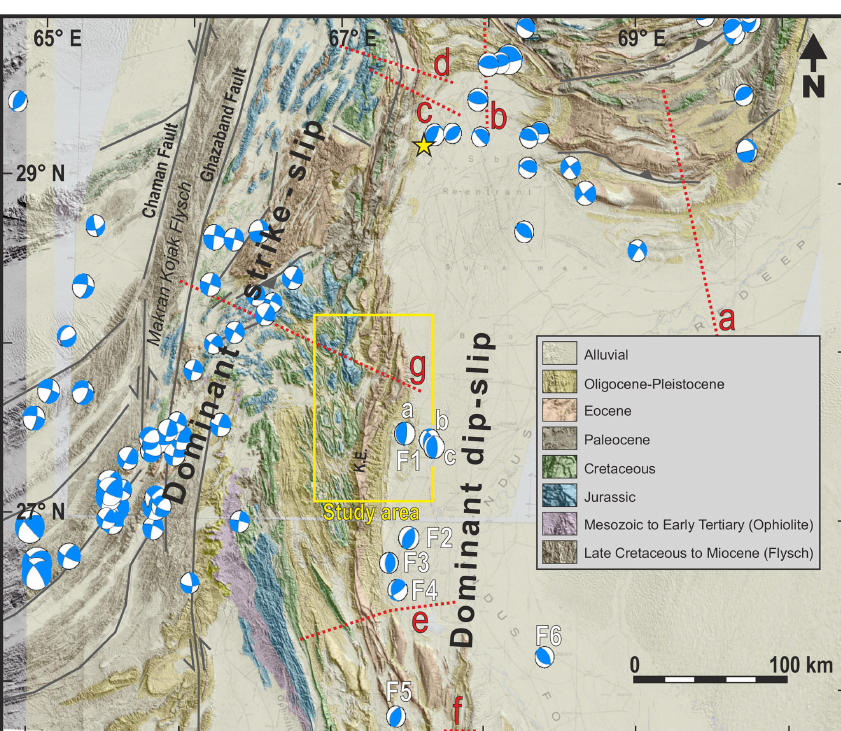
Figure 3. Nodal planes from the International Seismological Centre (2015) database, DEM with draped geological map after Bannert et al. (1992) and selected structural elements. Location of the figure is indicated in Fig. 1. Dotted red lines are locations of sections in Fig. 2. Labelled events are listed in Table 1. Yellow star marks the 1931 Mach event after Szeliga et al. (2009). K.E.: Kirthar Escarpment.